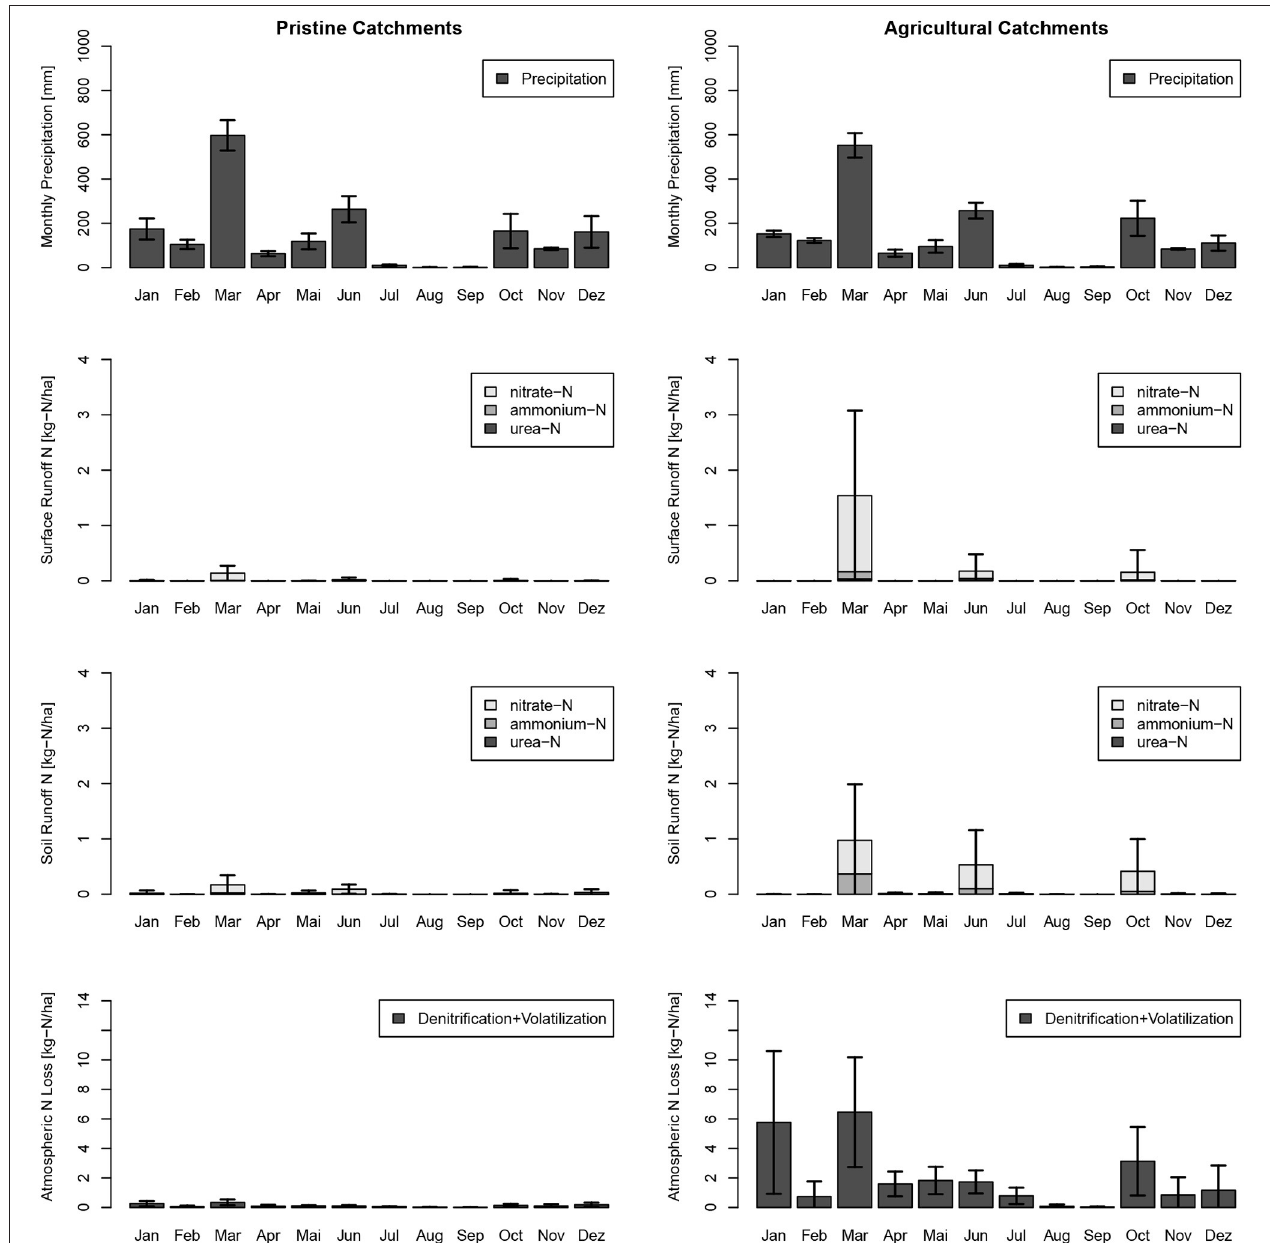
FIGURE 8 | Monthly urea-N, ammonium-N, and nitrate-N loads of the study site sub-catchments in immediate surface runoff (Surface Runoff) and retarded interflow (Soil Runoff) for the calibration year 2017. Results were split into pristine (no horticulture) and horticultural catchments, and standard deviations of the model results of all 146 pristine catchments and 71 horticultural catchments are